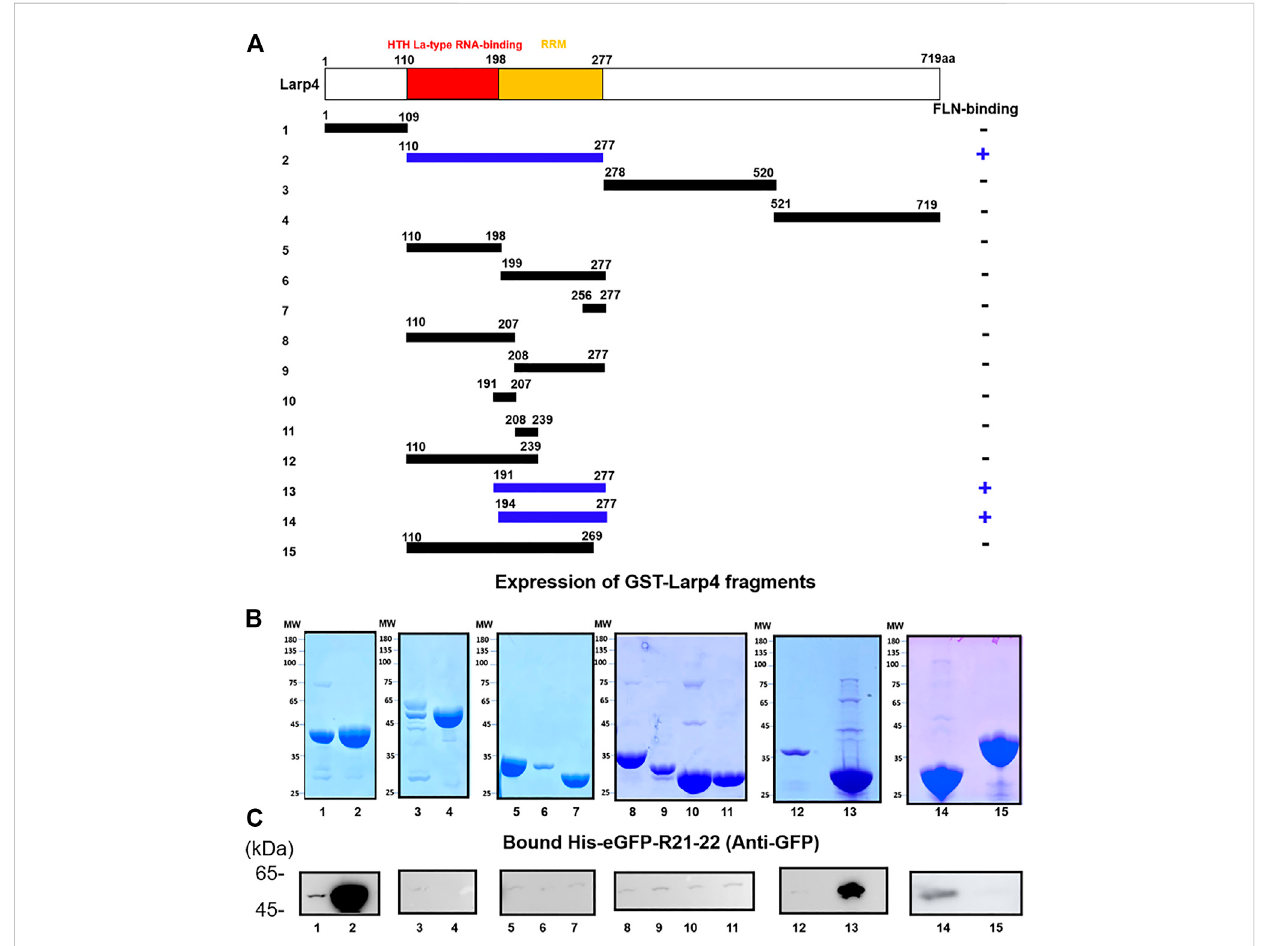
FIGURE 3 Schematic structure of Larp4 and identi fi cation of FLNA-binding domains on Larp4. (A) Structure of Larp4. RRM: RNA Recognition Motif. Blue indicatesfragmentsofLarp4thatbindtoFLNAR21. (B) CBBstainedgelof5 μ gofthepuri fi edGSTfusionprotein. (C)